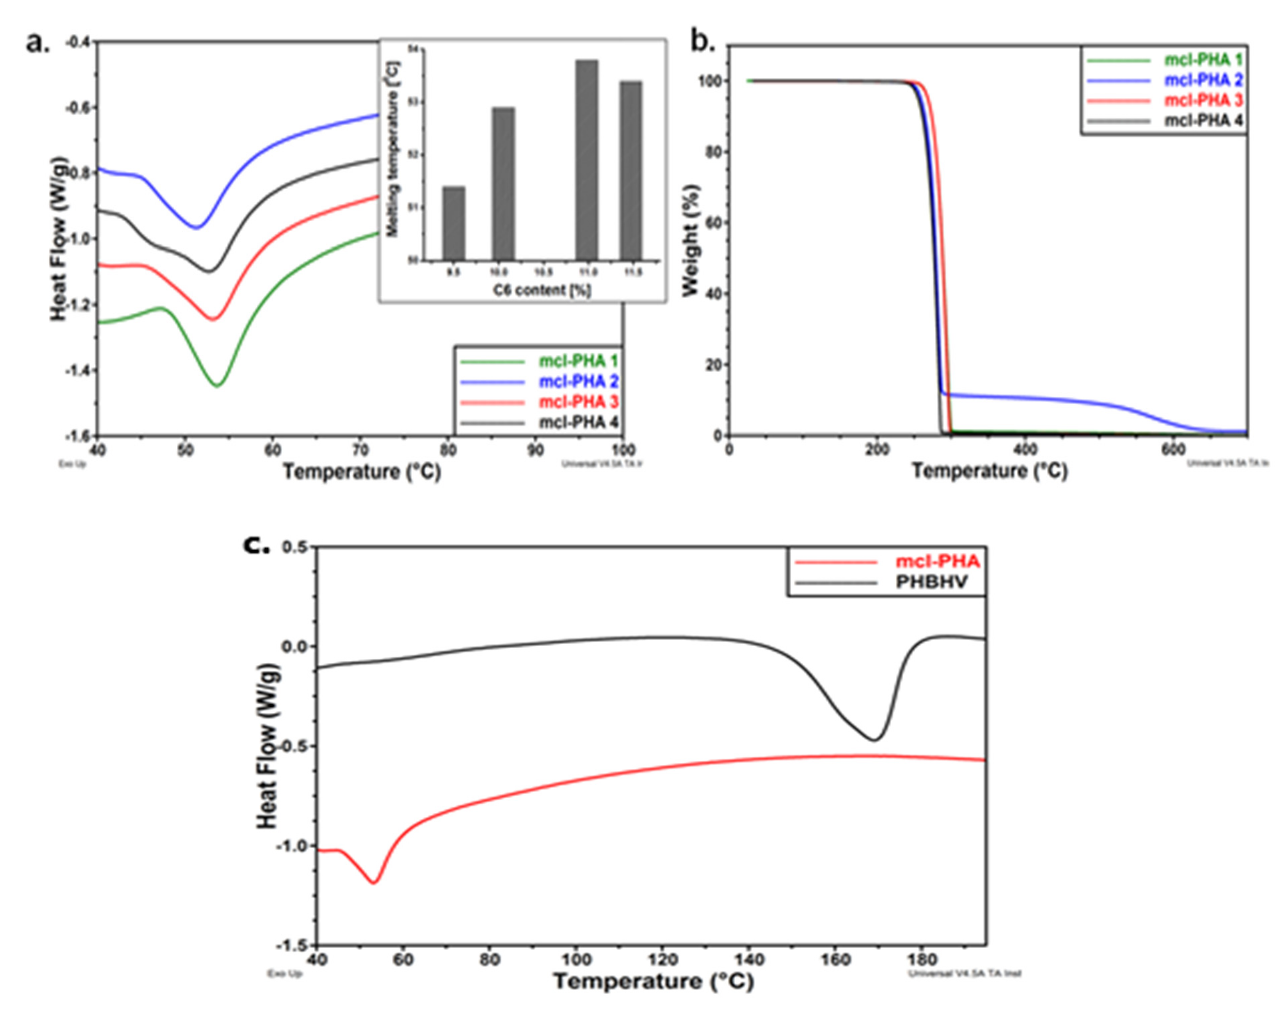
Figure 7. ( a ) DSC thermograms of mcl -PHAs (inset: melting temperature vs. C6 content in PHAs); ( b ) TGA curves of mcl -PHAs ( c ) DSC thermograms of mcl -PHAs and PHBHV. Reprinted with permission from ref. [66], 2016, Lupescu et al., Rev.Chim.